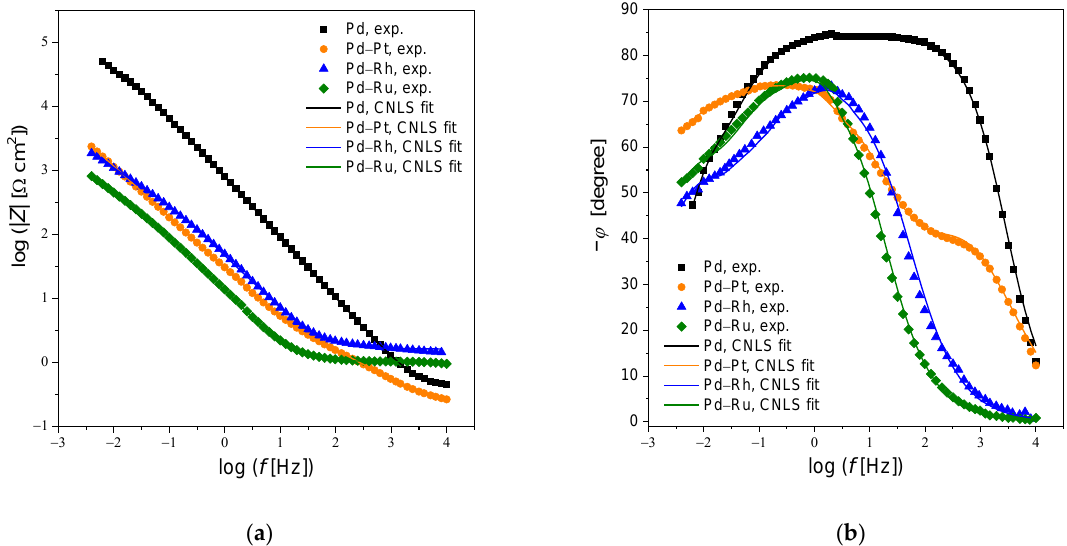
Figure 7. Bode plots versus log frequency ( log f ) for electrodeposited Pd, Pd-Rh, Pd-Ru and Pd-Pt electrodes in deaerated 0.5 M H 2 SO 4 at the open circuit potential: ( a ) Magnitude of impedance (log | Z |); ( b ) Phase angle ( ϕ ). Symbols represent experimental data. Continuous lines are fits obtained using the equivalent electrical circuit shown in Figure 6.